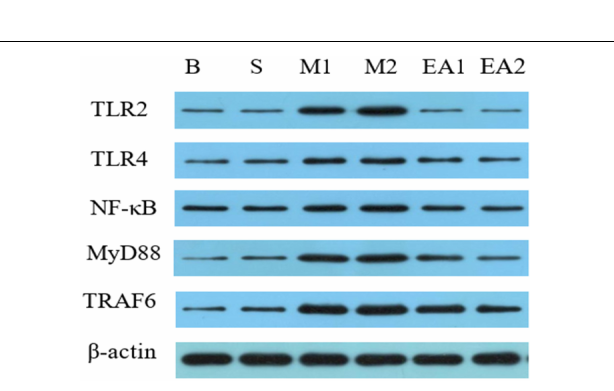
FIGURE 4 | Western blot detection of synovial TLR2, TLR4, NF- κ B, MyD88, and TRAF6 protein expression Western